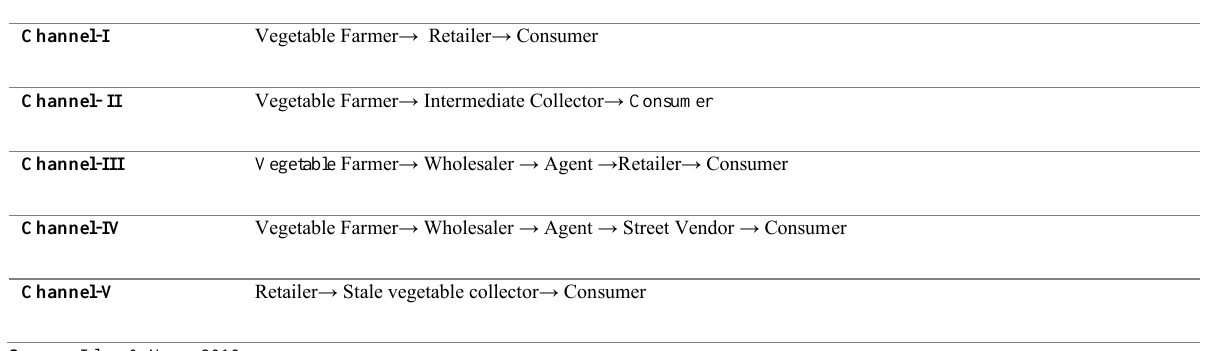
Table 2: Marketing channels of